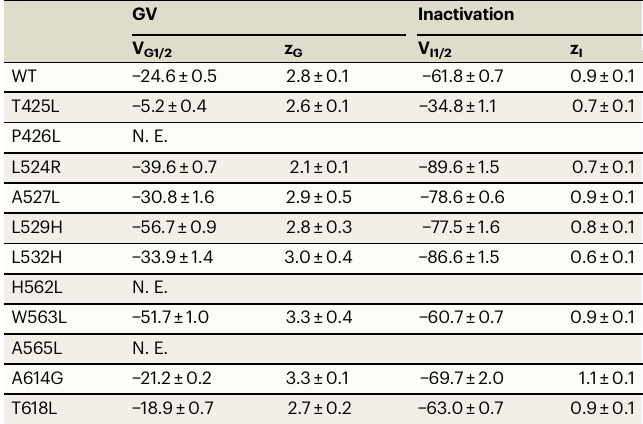
Table 1 | Fitted values for G-V and voltage-dependence of